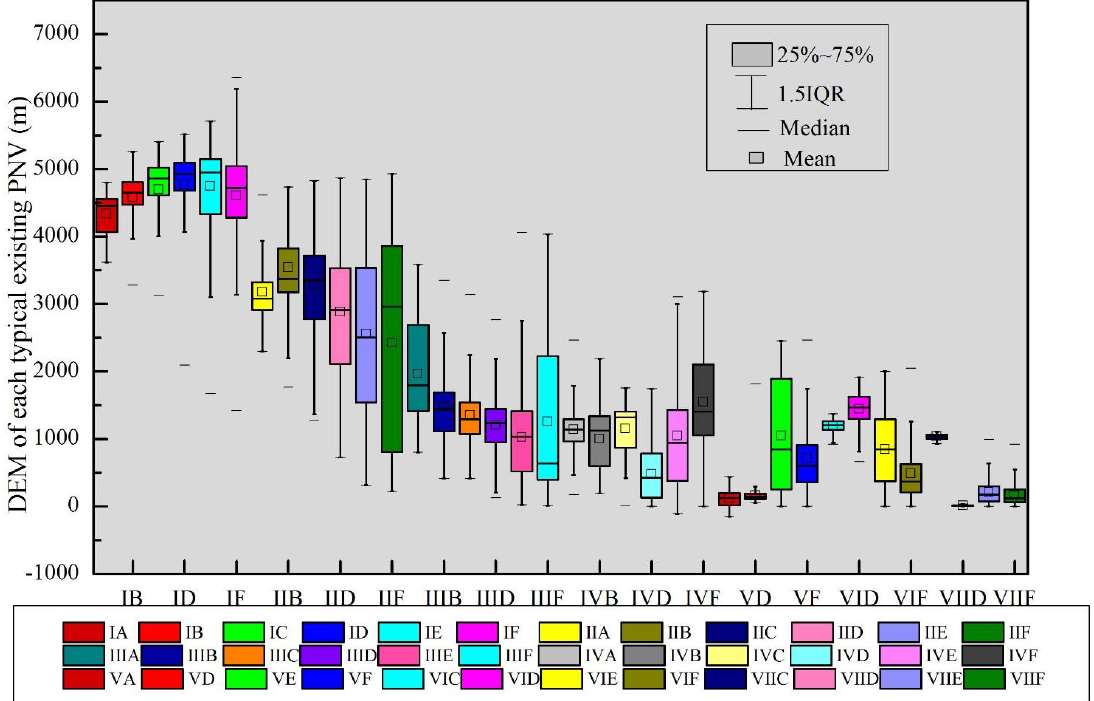
Figure 11. Statistical variability in DEM values for different PNV types. Refer to Table A2 for PNV classification code. IQR represents the interquartile range. classification code. IQR represents the interquartile